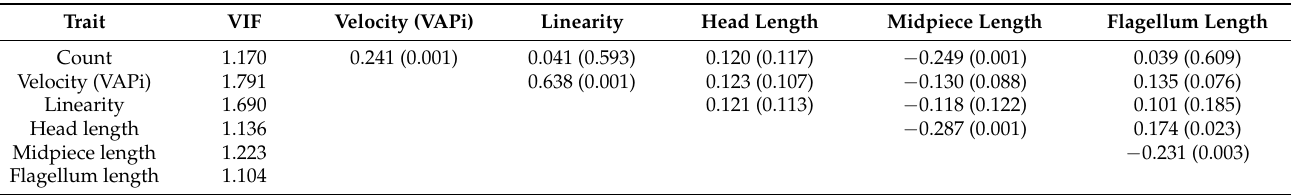
Table 3. Phenotypic correlations and trait collinearity. Variance inflation factors (VIF) are listed from the generalized linear model used to test significance of multivariate selection estimates. Phenotypic correlation coefficients ( r ) are listed for all pairwise combinations of ejaculate traits, with p -values in